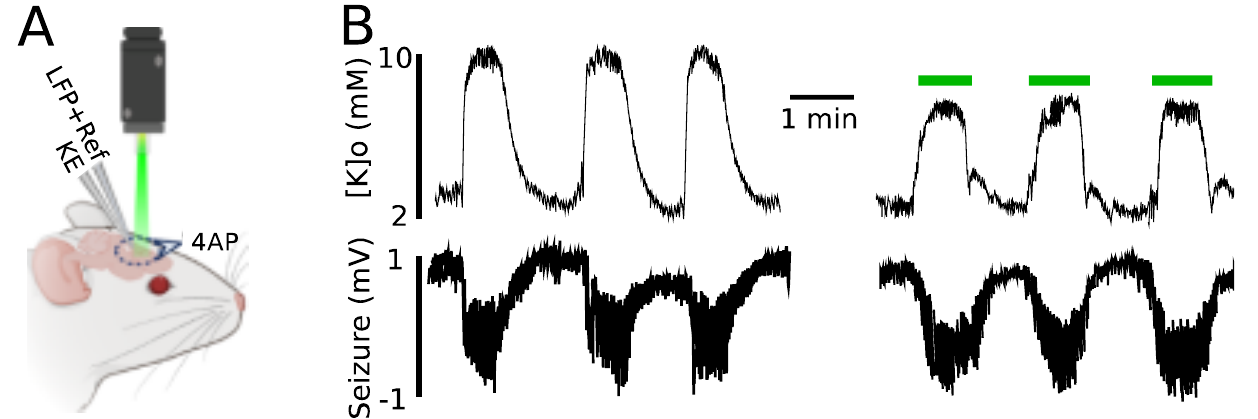
Figure 5. Evoked K responses triggered by 4AP reduced in amplitude following green light application. ( A ) Experimental configuration: topical 4AP application, K recording electrode (KE), local field potential recording electrode along with a local reference electrode for KE (LFP + Ref). ( B ) Top: [K]o during seizure activity in the presence and absence of light. Bottom: seizures induced by topical 4AP application recorded by LFP.